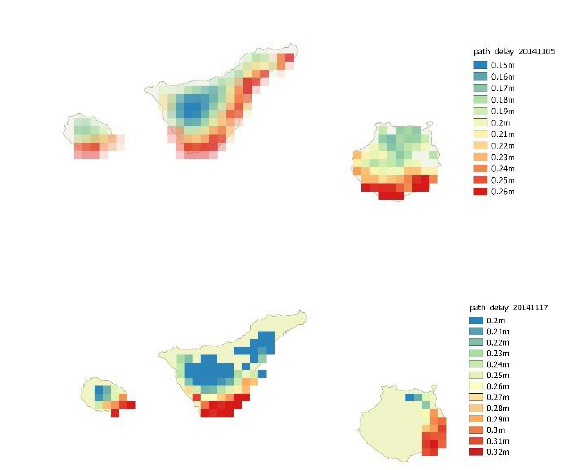
Figure 5. Master and Slave tropospheric path delays from MODIS data